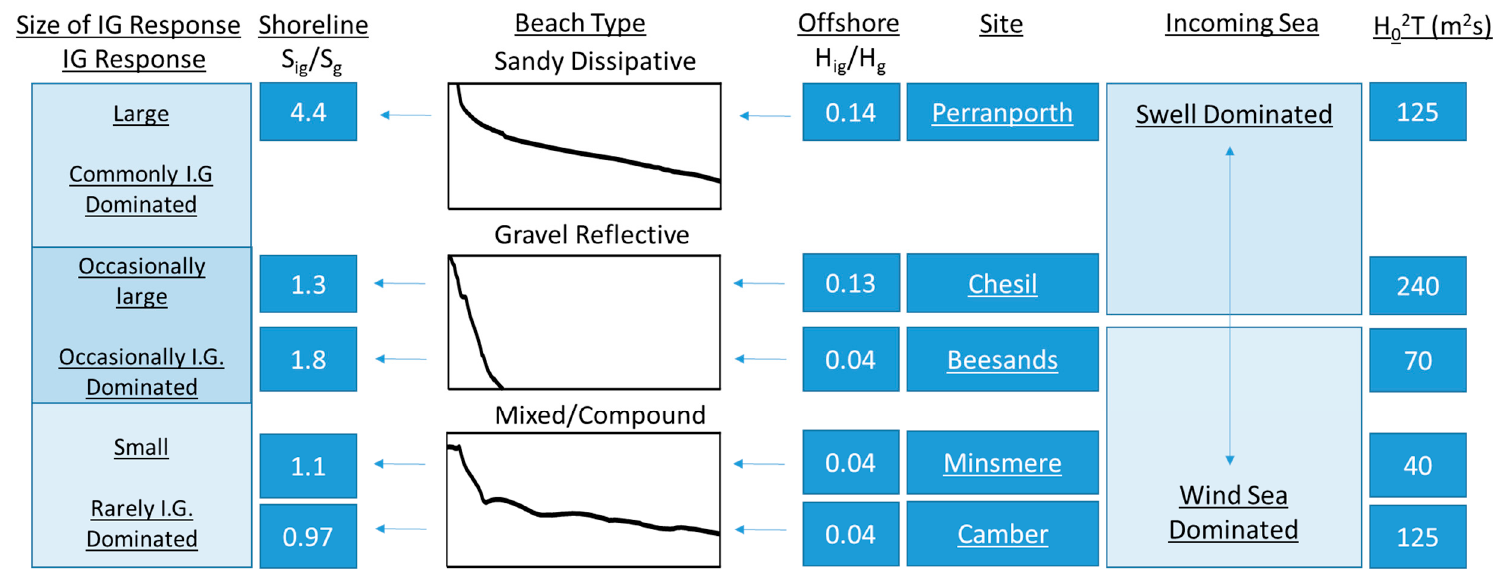
Figure 10. Conceptual diagram summarizing the contrasting development of infragravity energy at the shoreline on three distinct morphologies: sand, gravel, and mixed/compound. The numerical values used in the diagram are taken from Figure 4 and are representative of high-energy conditions at each site.